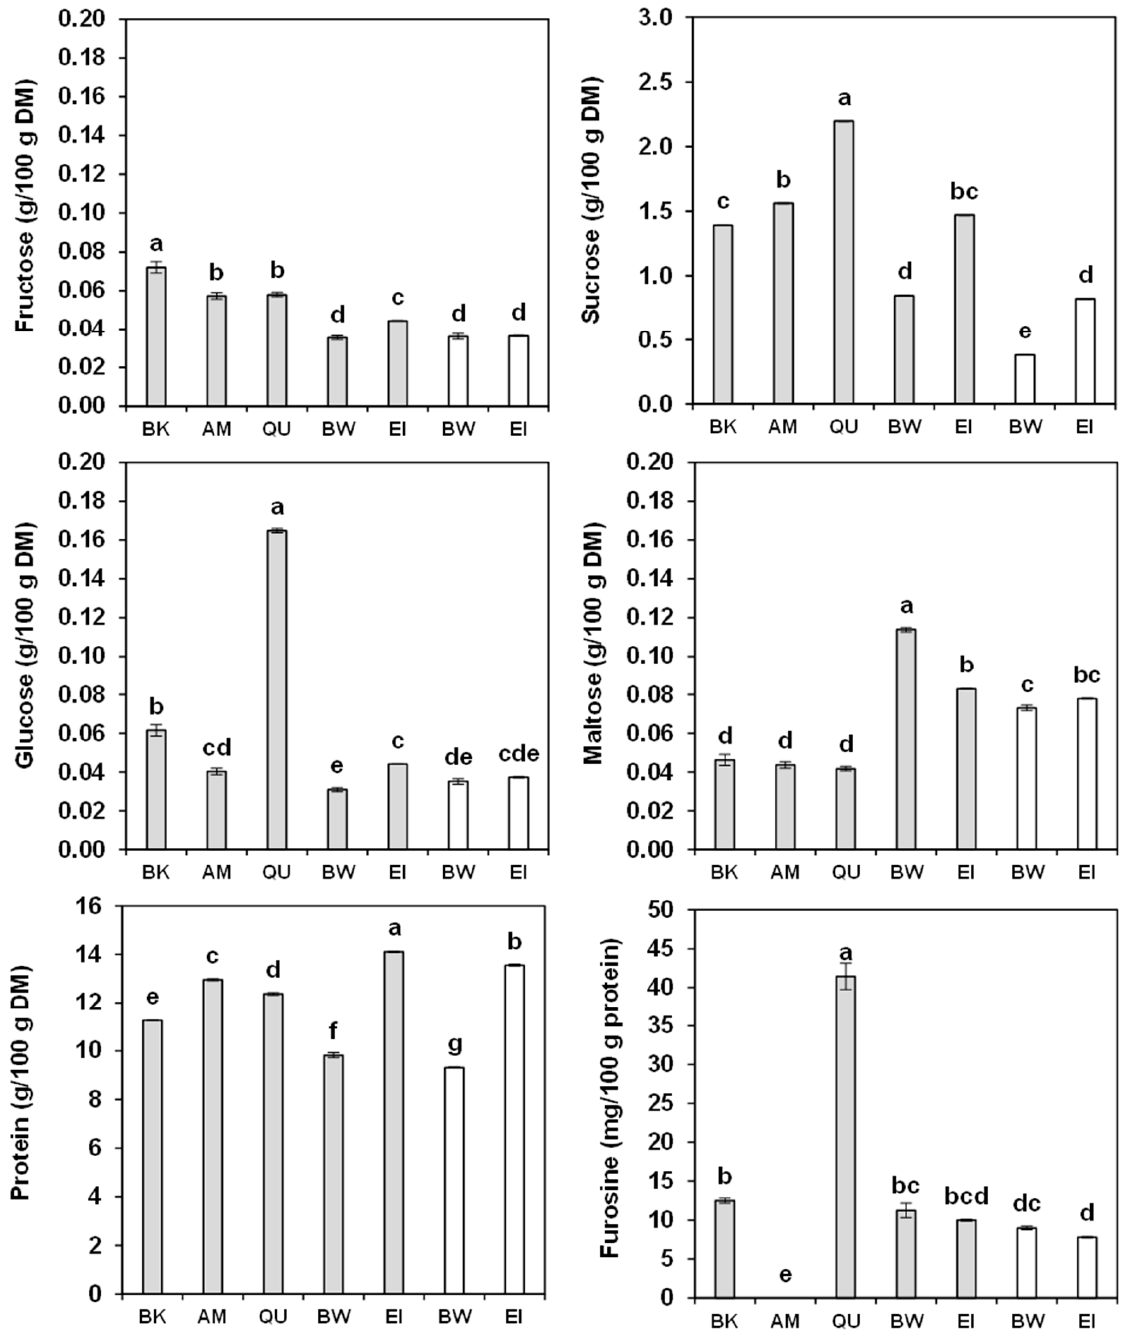
Figure 3. Fructose, glucose, maltose, sucrose, protein (g/100 g DM) and furosine (mg/100 g protein) content of the buckwheat (BK), amaranth (AM), quinoa (QU), bread wheat (BW) and einkorn (EI) wholemeals (grey bars) and of the bread wheat and einkorn refined flours (empty bars). The error bars represent the standard deviation; different letters indicate significant differences ( p < 0.05) among samples.